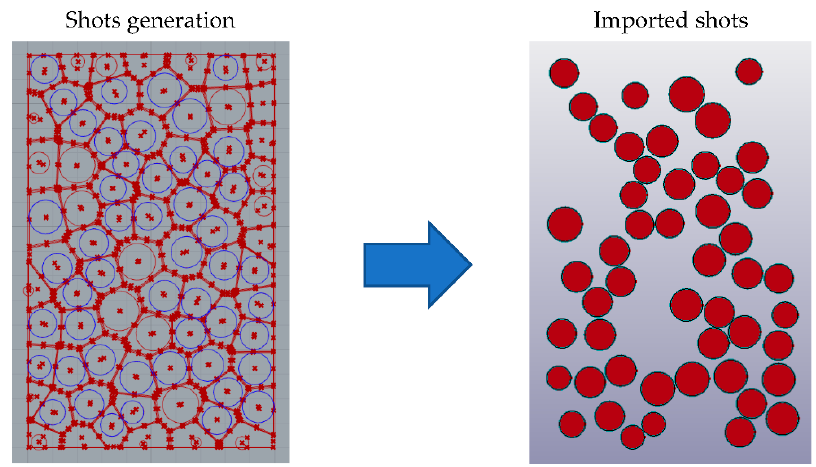
Figure 1. Shot generation using the Voronoi-based algorithm (on the left) and imported shots (shown as blue circles on the left) in the pre-/post-processor (on the right). A specific area above the specimen is divided into random polygons, and then the geometric center of every polygon is used for drawing a circle which represents a single shot. The diameter of each circle is calculated as a percentage of the minimum vertical